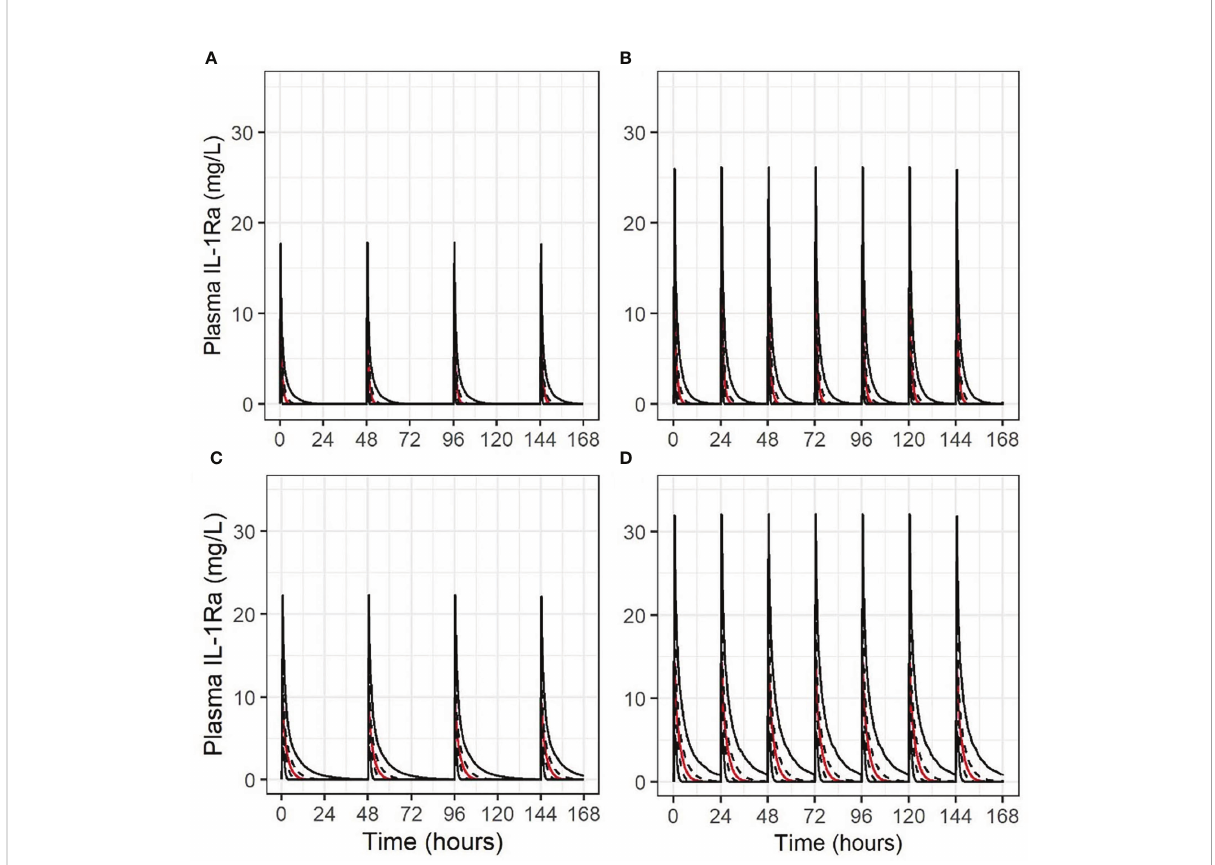
FIGURE 4 Concentration-time course for 1000 simulations (2.5 th /25 th /50 th /75 th /97.5 th centiles, indicated by solid, dashed, red, dashed and solid lines in this order, respectively), for different scenarios of anakinra IV dosing in an extremely premature neonate. (A) 1 mg/kg alternate daily, mature non-renal clearance; (B) 1.5 mg/kg daily, mature non-renal clearance; (C) 1 mg/kg alternate daily, non-renal clearance at 25% maturity; (D) 1.5 mg/kg daily, non-renal clearance at 25%